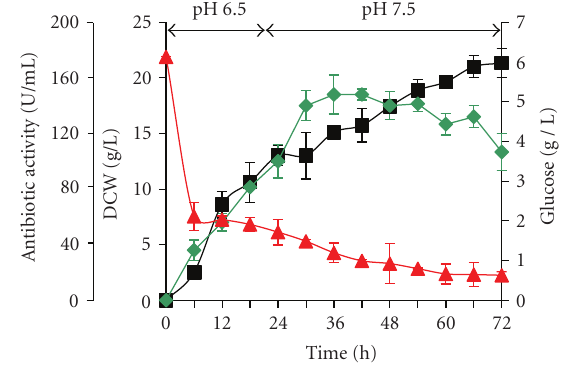
Figure 5: Two-stage batch fermentation with pH shifted from 6.5 to 7.5 after 24 h fermentation. Dry cell weight (DCW) ( ( ), and antibiotic activity ( (cid:3) ); pH 6.5 ( ); pH 7.5 ( ); and pH (cid:2) (cid:0) (cid:3)